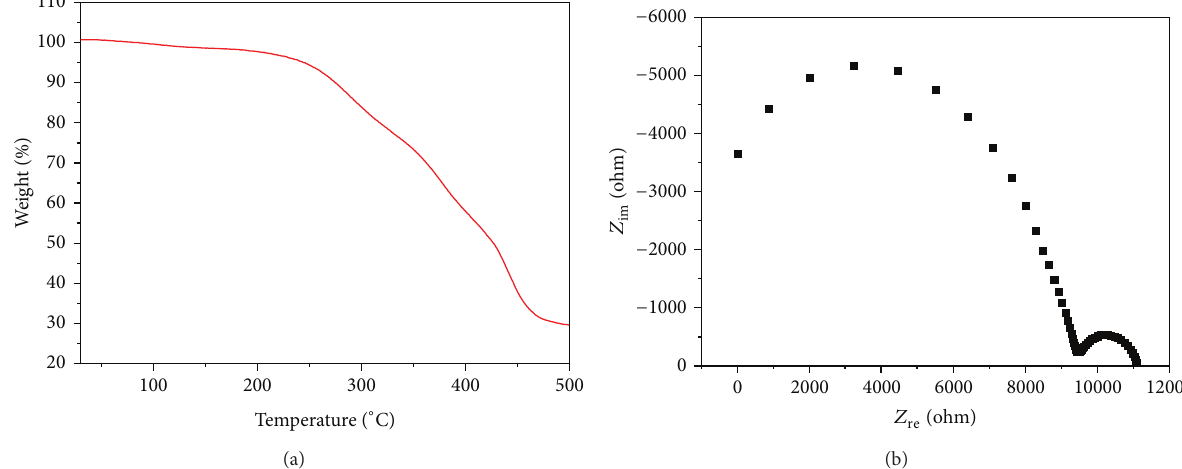
Figure 5: Thermogravimetric analysis (TGA) curves (a) and an impedance plot (b) of AEM prepared by photocopolymerization.